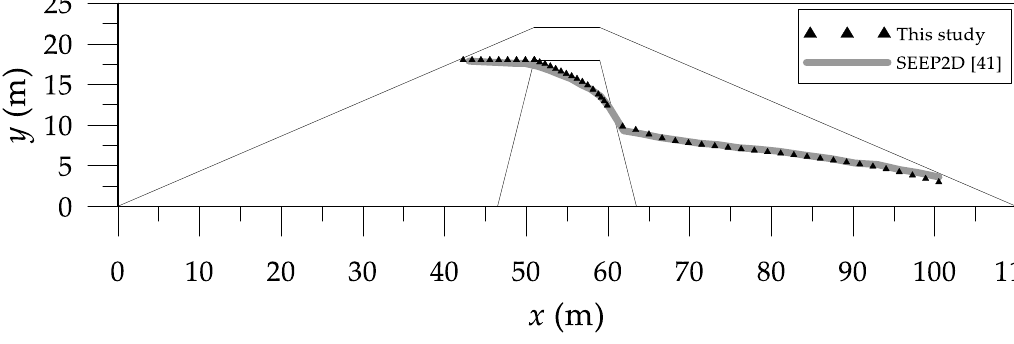
Figure 14. Comparison of the computed free surface with SEEP2D.